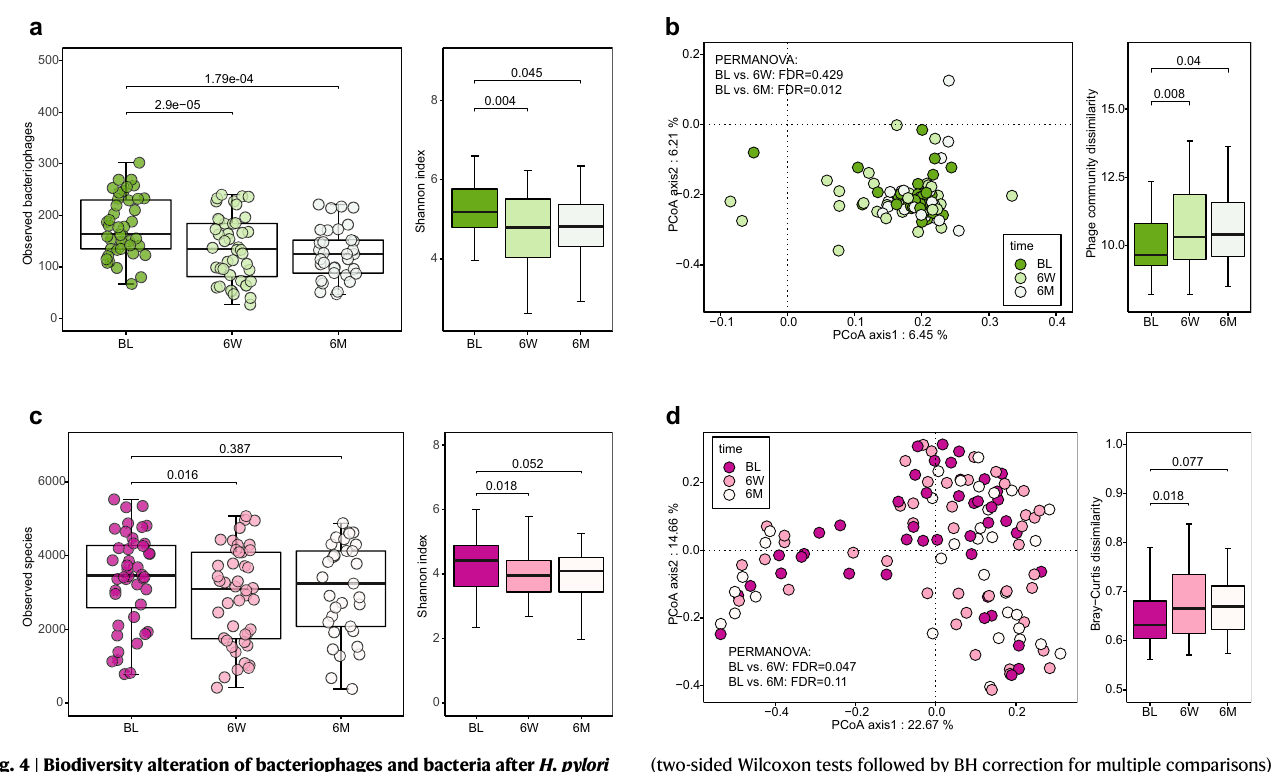
(two-sided Wilcoxon tests followed by BH correction for multiple comparisons) between three groups (BL: N =44; 6W: N =44; 6M: N =33). d PCoA plot shows the alteration of the bacteria community after the eradication therapy based on the bacterial community dissimilarity distance at the bacteria species level (PERMA- NOVA tests followed by BH correction) between three groups (BL: N =44; 6W: N =44; 6M: N =33). Comparisons of dissimilarity distance of bacteria community afterthe eradicationtherapy. The boxes denote the lower 25% quantile, upper 75% quantile, and center line the median, with whiskers extending to a limit of ±1.5 interquartile ranges